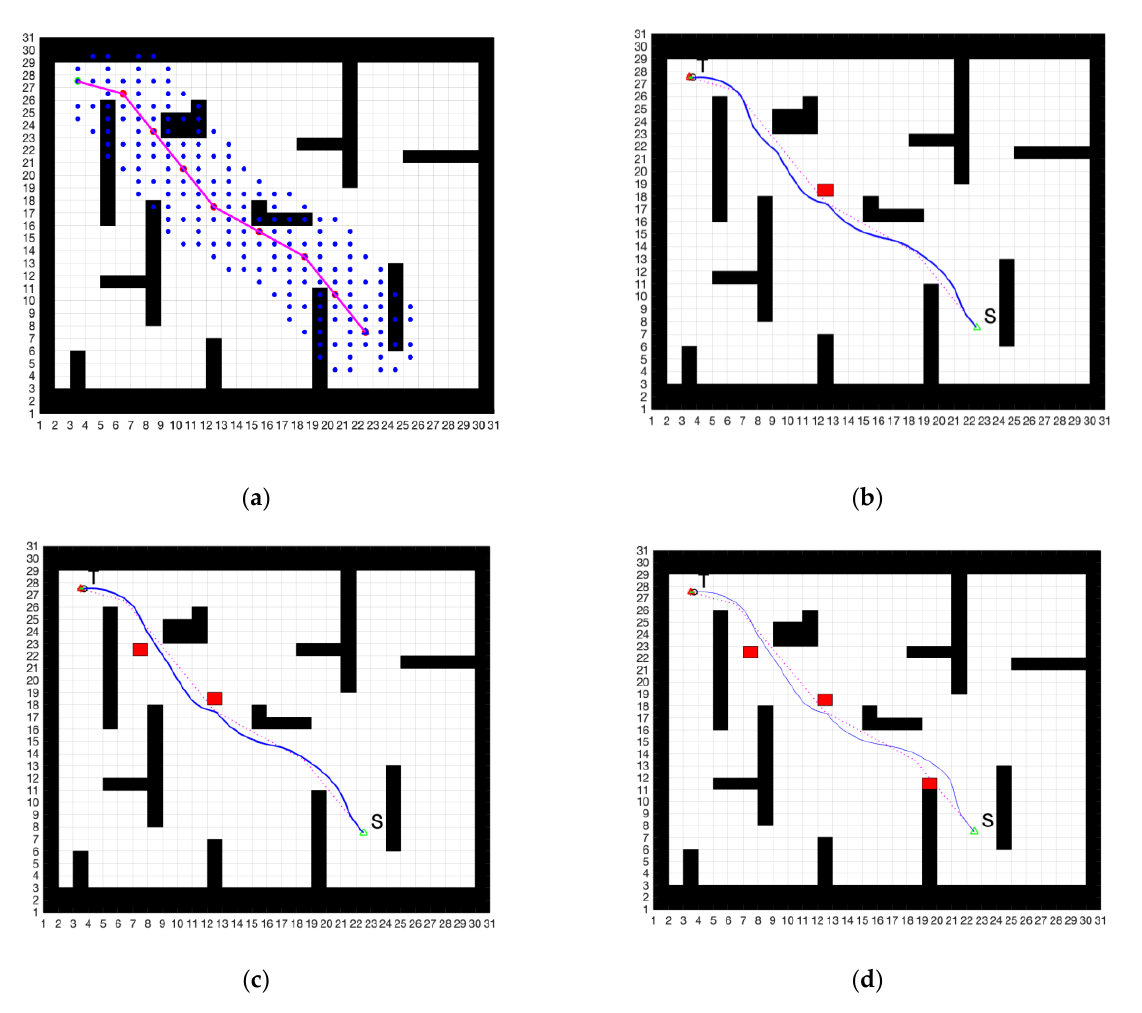
Table 3. Path planning performance of improved A* algorithm fusing dynamic window method.